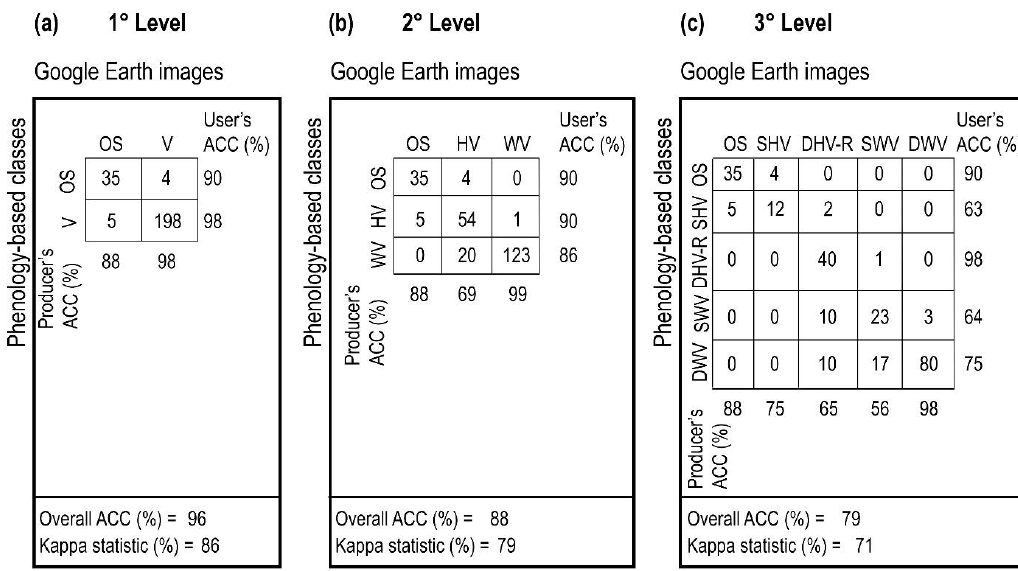
Figure 4. Error matrix, Accuracy (ACC) values, in particular Overall ACC, Producer’s ACC, User’s